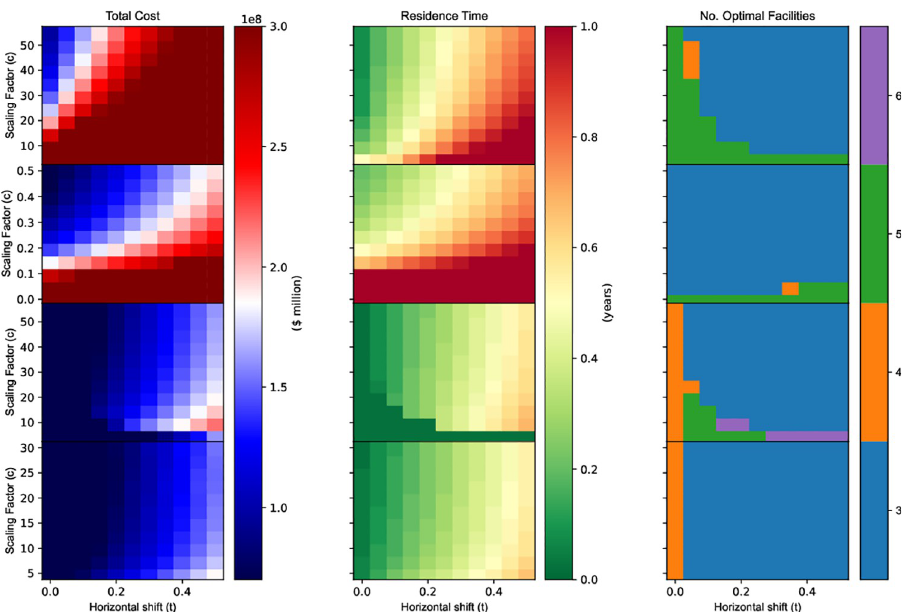
Fig 7. Impact of change in gradient ( c ) and horizontal shift ( t 0 ) on optimal solutions for different survival curve relationships. The asymptotic, linear, logistic, and pseudo-gamma distributions are plotted in panels a, b, c; d, e, f; g, h, i; and j, k, l; respectively. Column 1 (panels a, d, g, j) show total cost of the optimal solution, represented by the objective value from $70 million to $300 million. Column 2 (panels b, e, h, k) show growth time (years) from 0 to 1 year in 0.02 increments. Column 3 (panels c, f, i, l) show optimal number of facilities from 3 to 6.